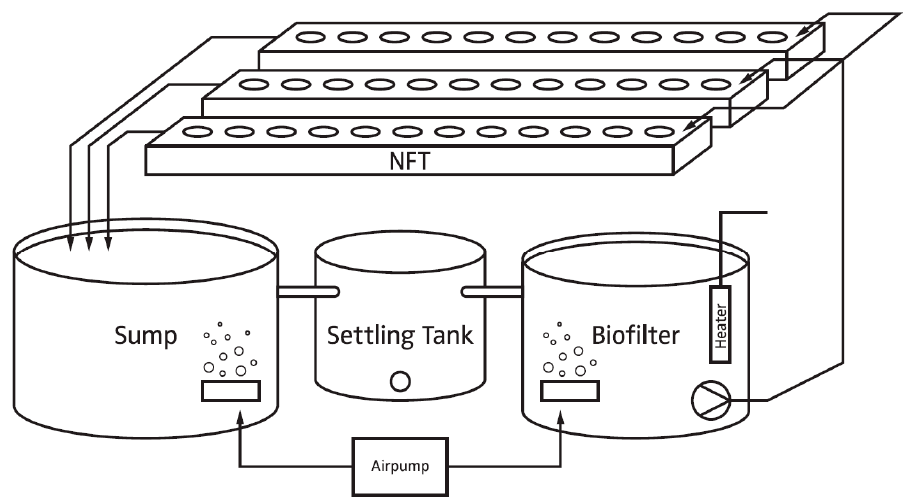
Figure 1. Schematic outline of the experimental systems comprising a sump (max. 280 L), a settling tank (70 L), and a biofilter (110 L). Extensive aeration with an air pump ensured reduction of chemical oxygen demands (CODs) as well as optimal dissolved oxygen (DO) in the process water for plant growth. Undiluted AER and ANA supernatants as well as Recirculating Aquaculture System (RAS) water entered the system via the sumps of the respective systems three times a week. Samples for measurements were taken in the sump at least 24 h after the supernatants or RAS water were added.